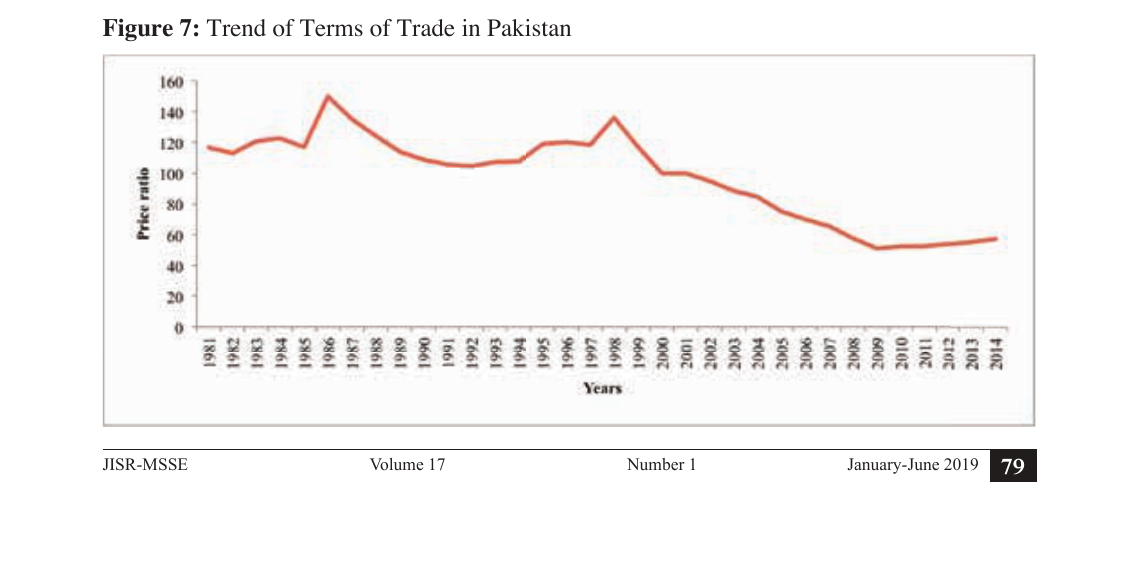
Figure 7: Trend of Terms of Trade in